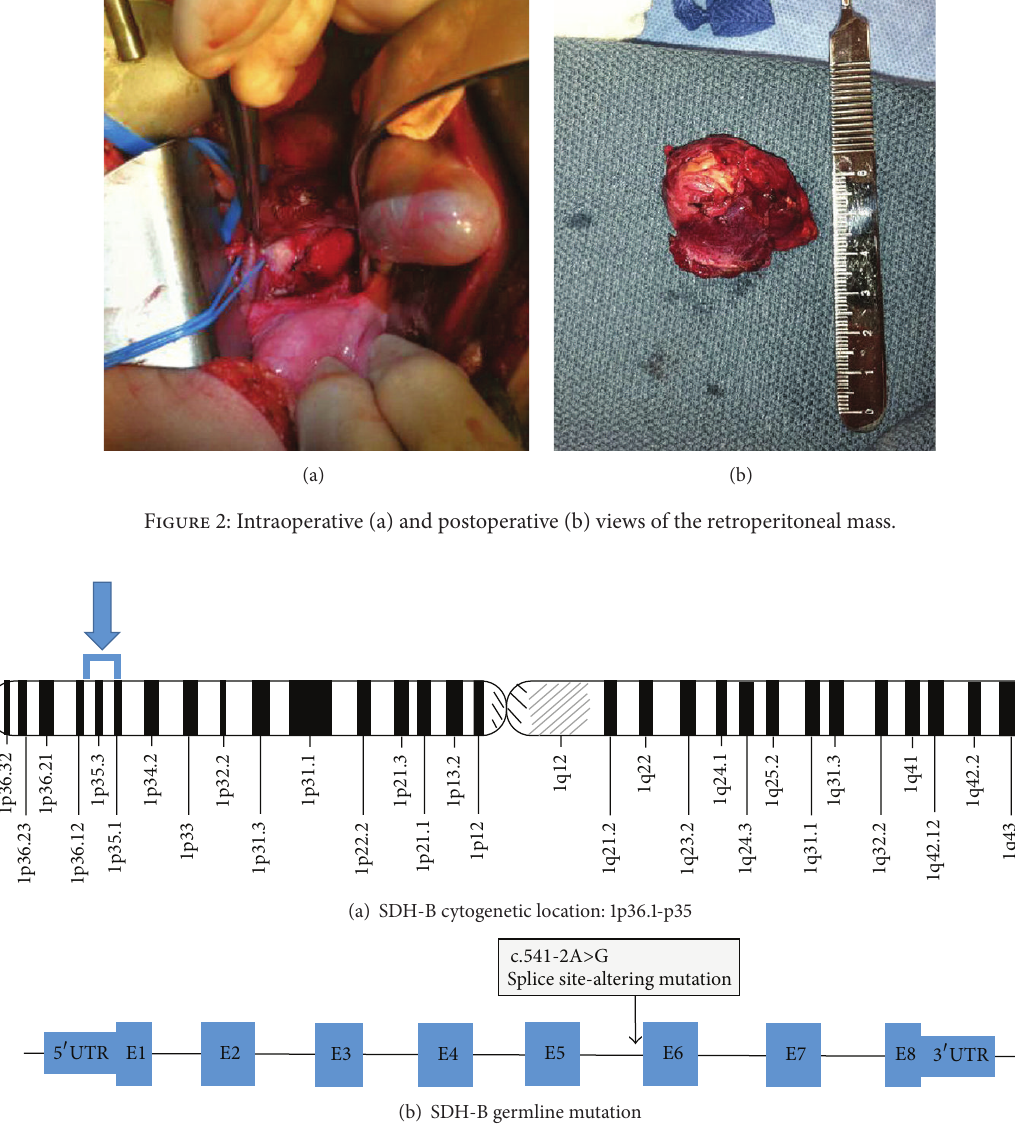
chest, abdomen, and pelvis showed no evidence of local or metastatic tumor recurrence. Plasma and urine cate- cholamines and chromogranin A were again found to be in normal ranges. He is now being followed on an annual